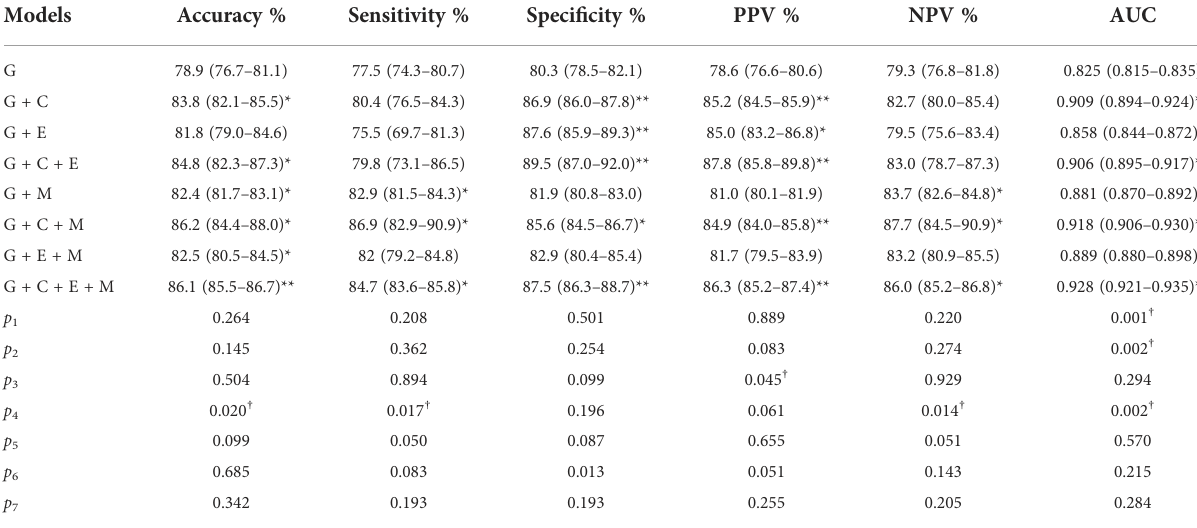
TABLE 2 Comparing the deep learning diagnostic performance based on multimodal ultrasound images.